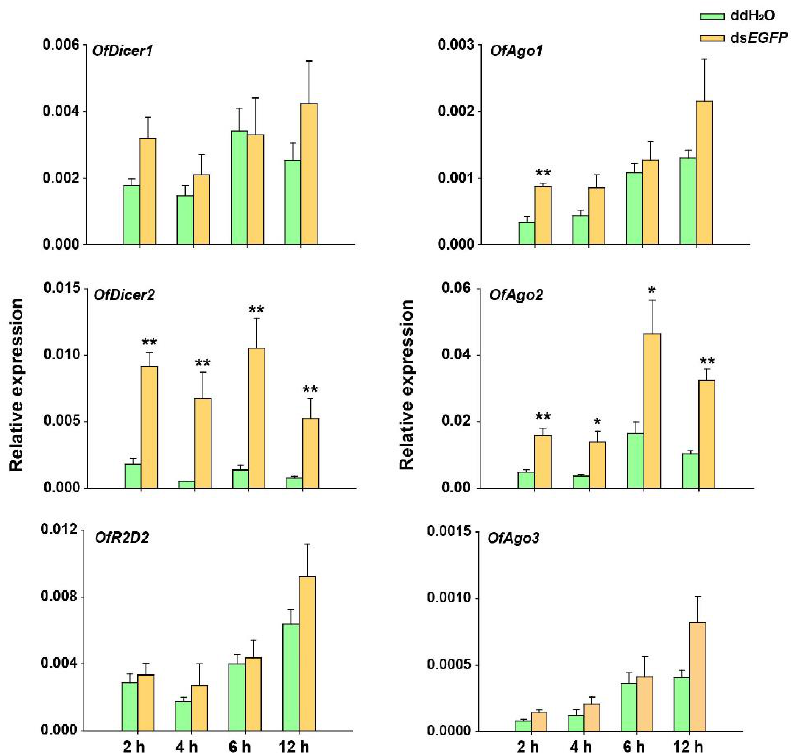
Figure 3. RT-qPCR analyses of relative expression of Dicer1 , Dicer2 , Ago1 , Ago2 , Ago3, and R2D2 in O. furnacalis at different time-points after each larva was injected with 5 µ g ds EGFP . ddH 2 O was injected in the negative control. Each treatment consisted of five replicates and three individuals were pooled in each replicate. Student’s t -test was used in statistical analysis of the data (* p < 0.05, ** p < 0.01).